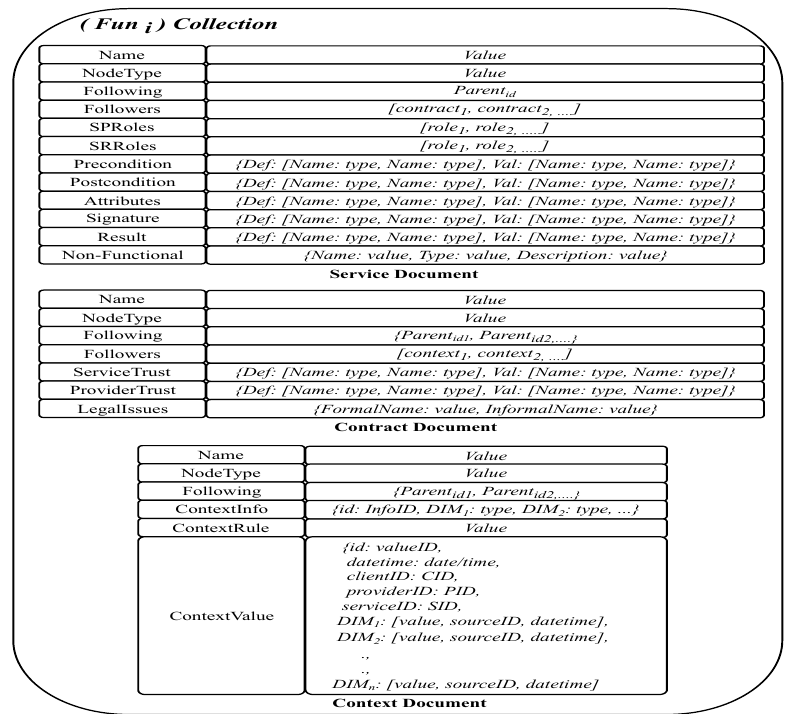
Figure 7. Things Collection Clustered by